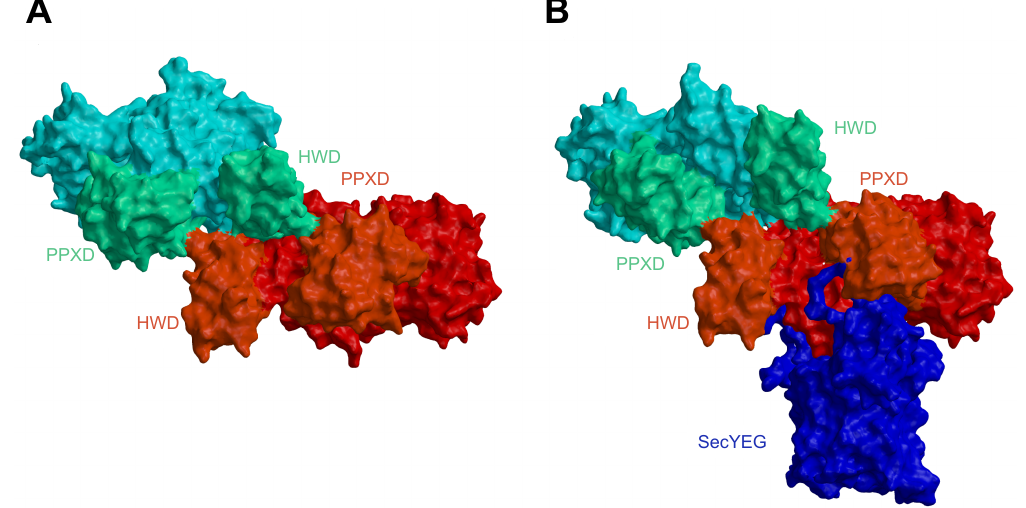
Figure 4. Model of the CDSecA2 dimer. ( A ) CDSecA2 dimer in the open conformation modeled based on B. subtilis SecA (PDB ID 3JV2) with one CDSecA2 molecule shown in red and the other in cyan. Interacting PPXDs and HWDs are highlighted. ( B ) CDSecA2 dimer in the SecY-bound conformation modeled based on T. maritima SecYEG (blue)-bound SecA dimer (PDB ID 3DIN). CDSecA2 dimer color coding is the same as in